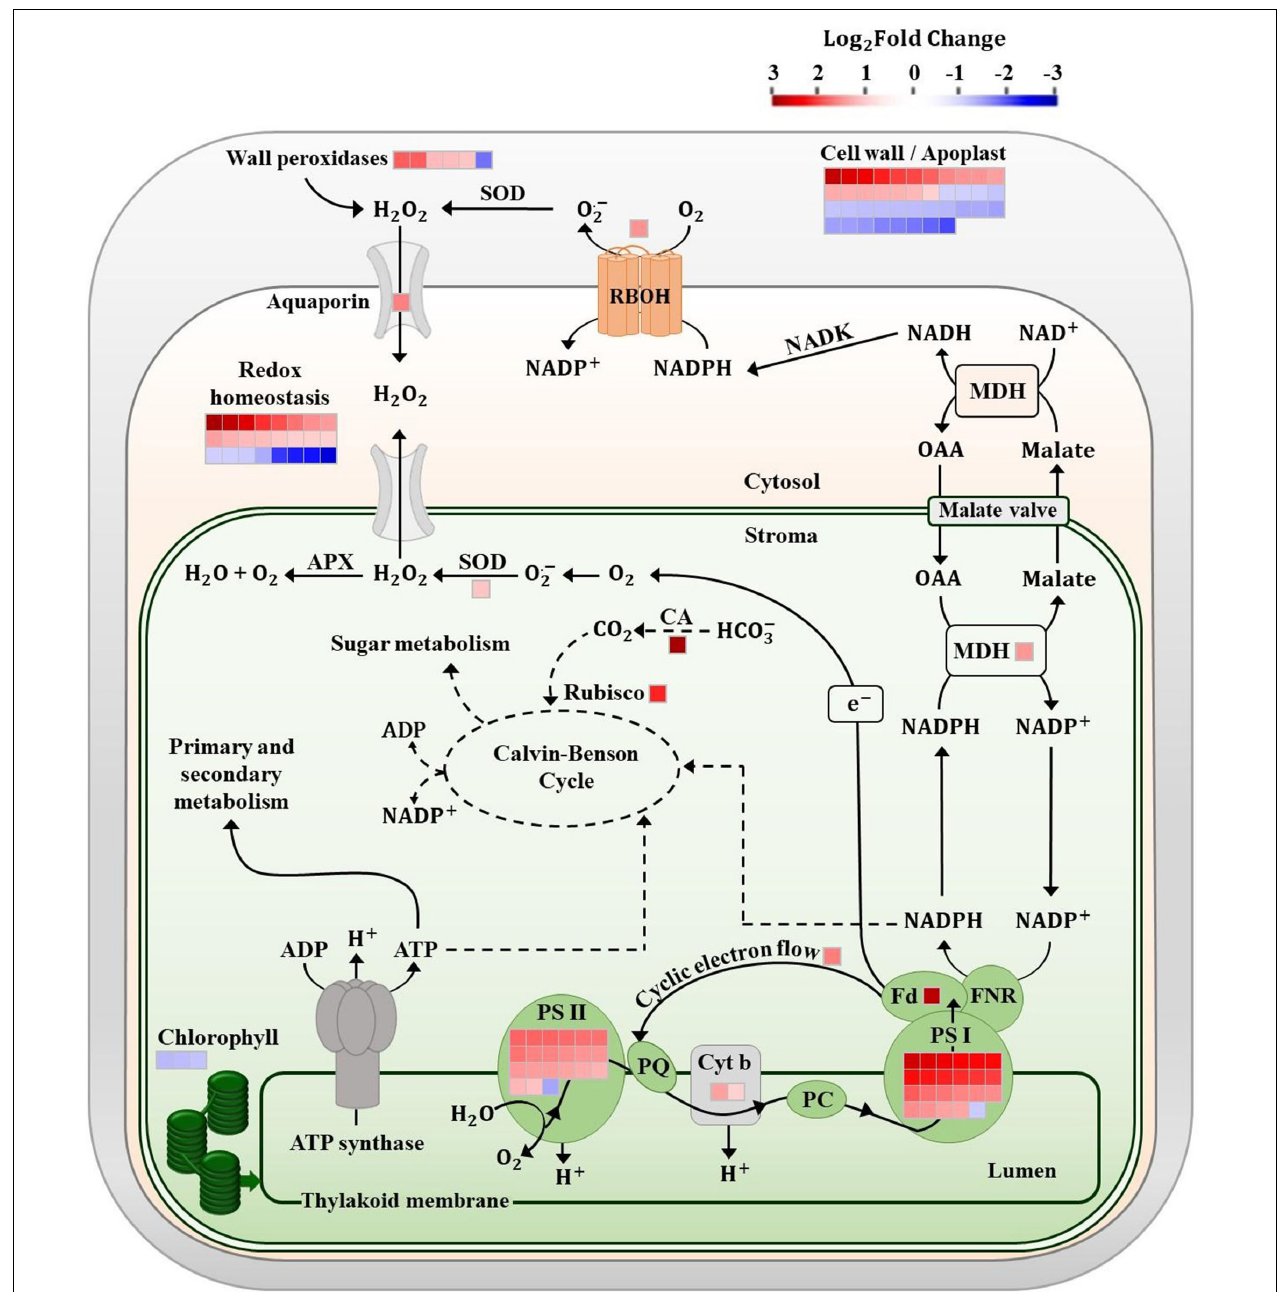
FIGURE 9 | Chloroplast electron chain and redox homeostasis in tomato leaves after three sprayings with chitooligosaccharides–oligogalacturonides (COS-OGA; 62.5 mg/l). The electrons produced by the chloroplast light phase are used for CO 2 reduction, reduced nicotinamide adenine dinucleotide phosphate (NADPH) production in the cytosol via the malate valve, and H 2 O 2 accumulation. Differentially expressed genes in elicited versus control leaves are represented by squares [false discovery rate (FDR) < 0.05; | log 2 Fold Change| > 1]. Squares are colored in red and blue if they are upregulated and downregulated, respectively. APX, ascorbate peroxidase; CA, carbonic anhydrase; Cyt b, cytochrome b; Fd, ferredoxin; FNR, ferredoxin NADP + reductase; MDH, malate dehydrogenase; NADK, NAD kinase; OAA, oxaloacetic acid; PC, plastocyanin; PQ, plastoquinone; PS, photosystem; and SOD, superoxide